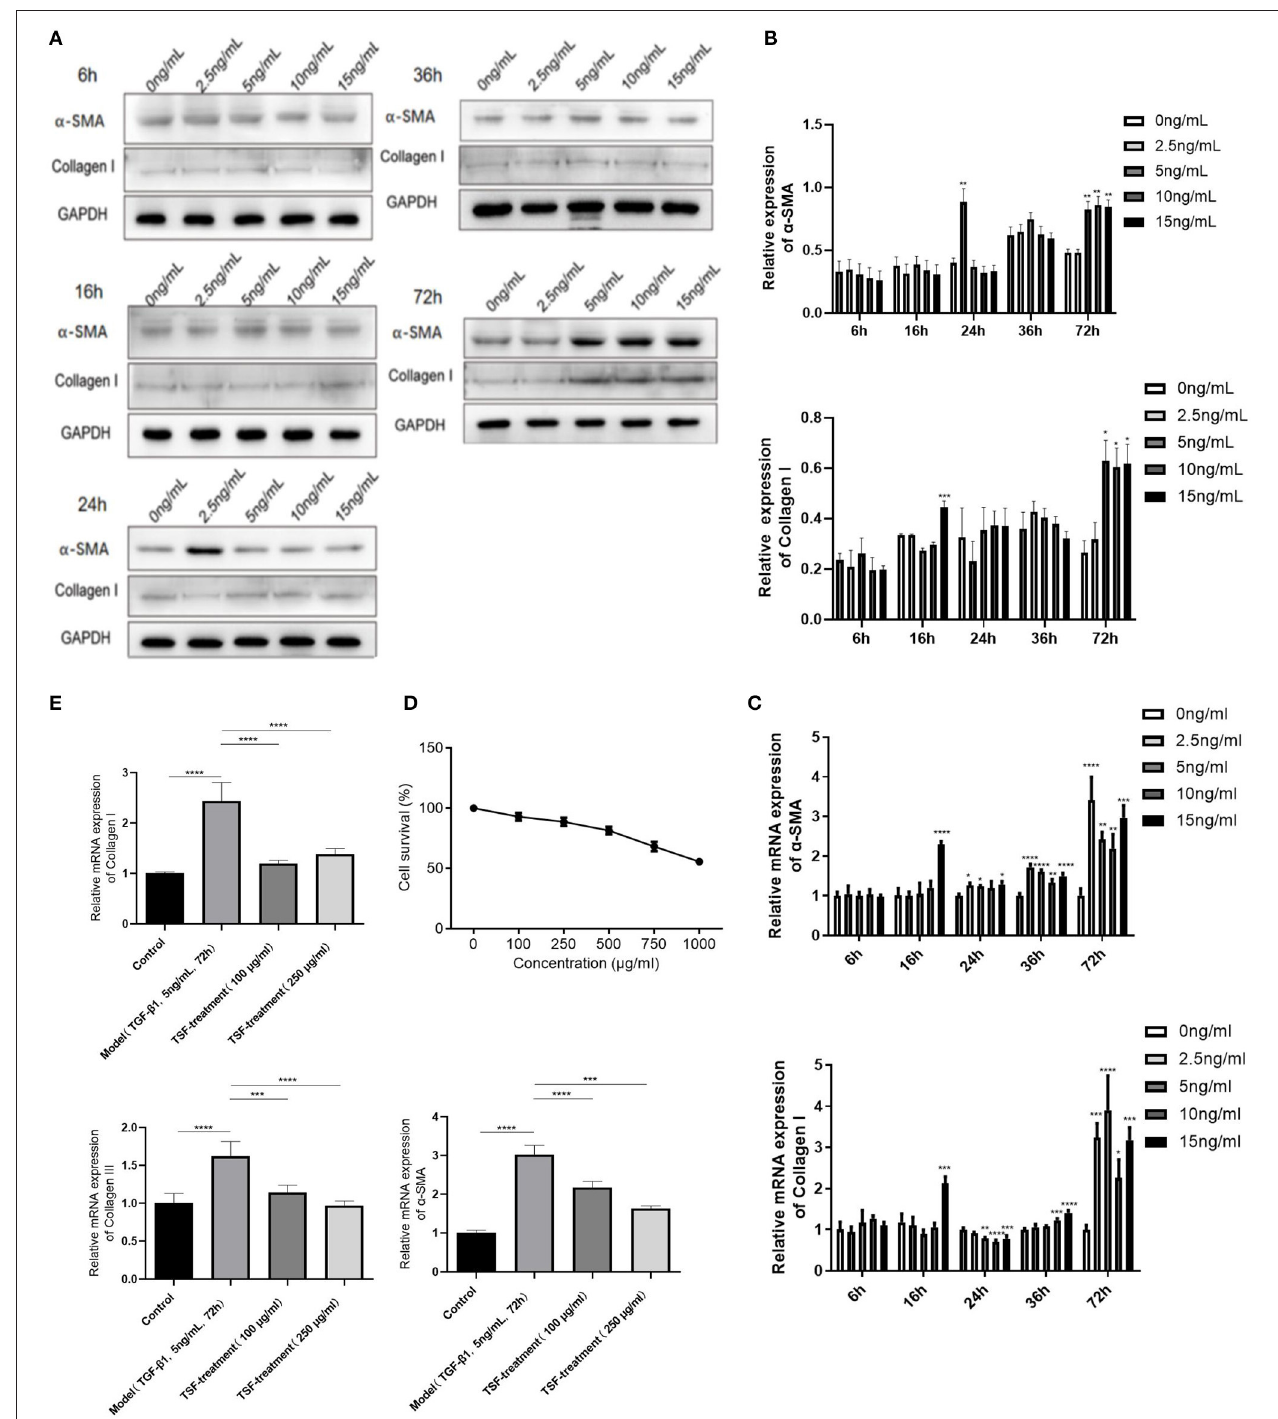
FIGURE 5 | An inhibitory effect of TSF against the activation of the TGF- β /smad pathway in vitro . (A) The expression of fibrosis index protein in cardiac fibroblast (CF) cells stimulated by TGF- β in different concentrations at different times. (B) Quantitative analyses of protein expressions. (C) Quantificational real-time polymerase chain reaction (qRT-PCR) of messenger RNA (mRNA) expressions of fibrosis index of CFs induced by TGF- β 1. (D) Effects of different concentrations of TSF on the survival rate of cells. (E) qRT-PCR of mRNA expressions of collagens I and III and α -SMA in CFs induced by TGF- β 1 in the different groups. Data are presented as mean ± SEM. * p < 0.05, ** p < 0.01, *** p < 0.001, **** p < 0.0001.